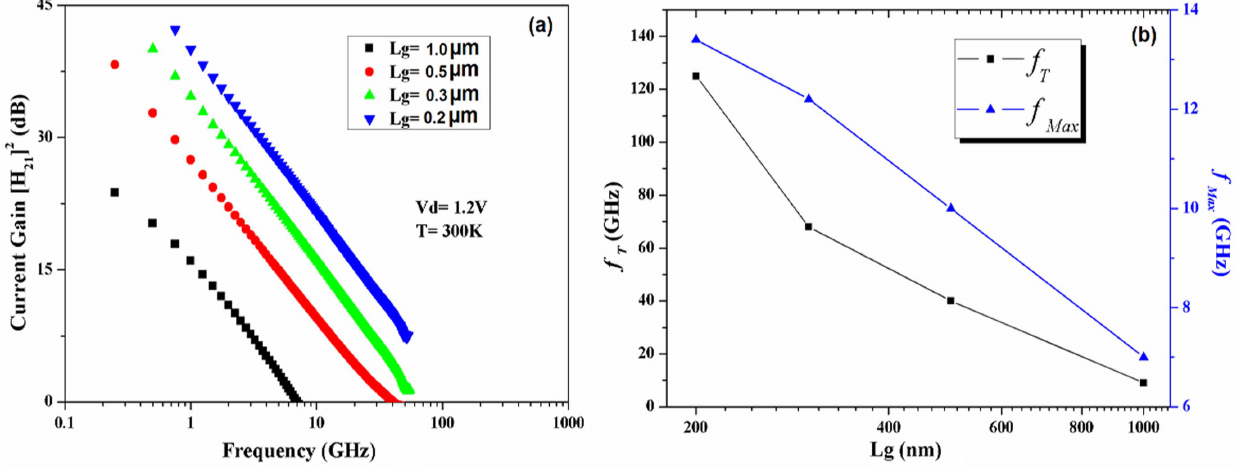
Figure 9. Extrinsic current gain H21 versus frequency (a), f T and f Max values (b) for different L g of In 0.53 Ga 0.47 As MOSFETs. doi:10.1371/journal.pone.0082731.g009 PLOS ONE |